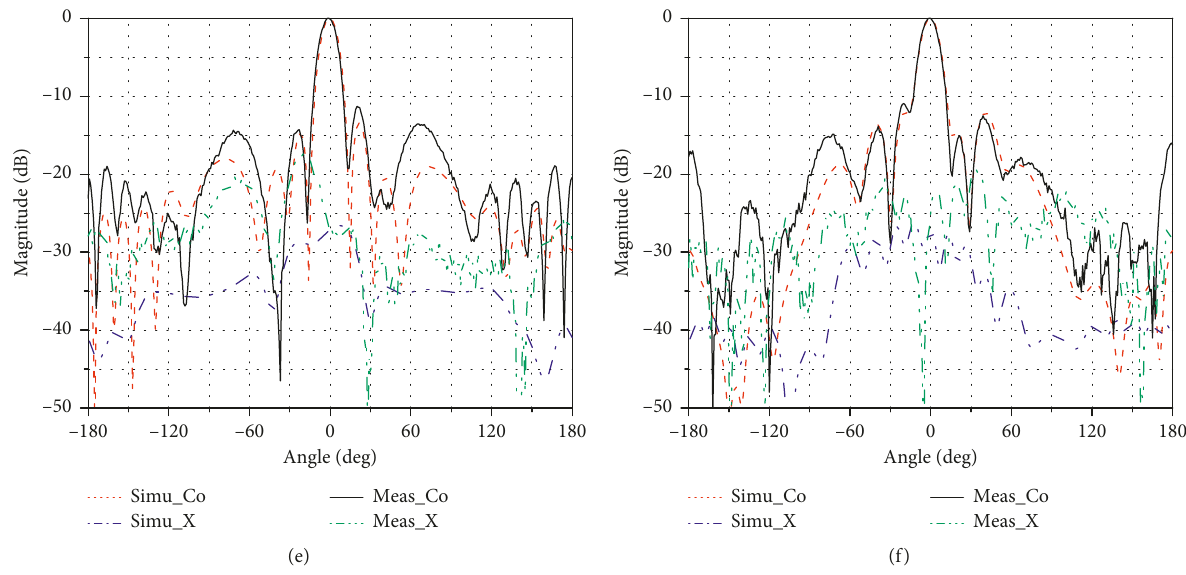
Figure 20: The simulated and measured co- and cross-polarization radiation patterns of the proposed antenna array at different frequencies. (a) E-plane at 13GHz. (b) H-plane at 13GHz. (c) E-plane at 15GHz. (d) H-plane at 15GHz (e) E-plane at 17 GHz. (f) H-plane at 17 Table 5: Comparison to other antenna elements/arrays.